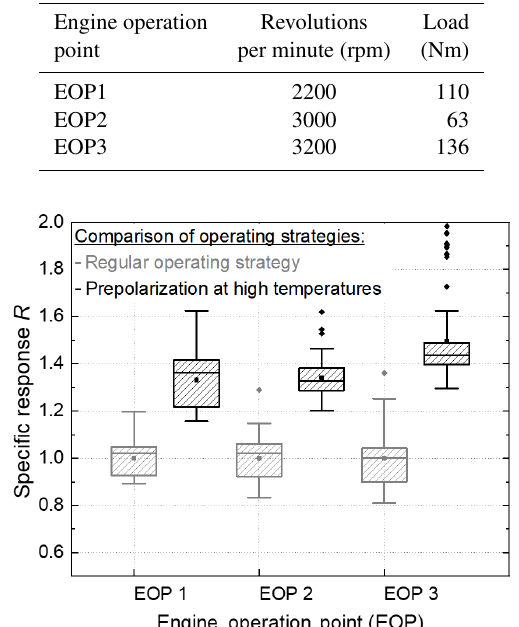
Figure 4. Specific response at three different engine operation points for each of the five sensors operated by either the regular strategy or prepolarization at high temperatures. The values of R are scaled to the mean specific response of the regular operated sen- sors at each EOP. The experiment was carried out at the BMW N47 test bench.